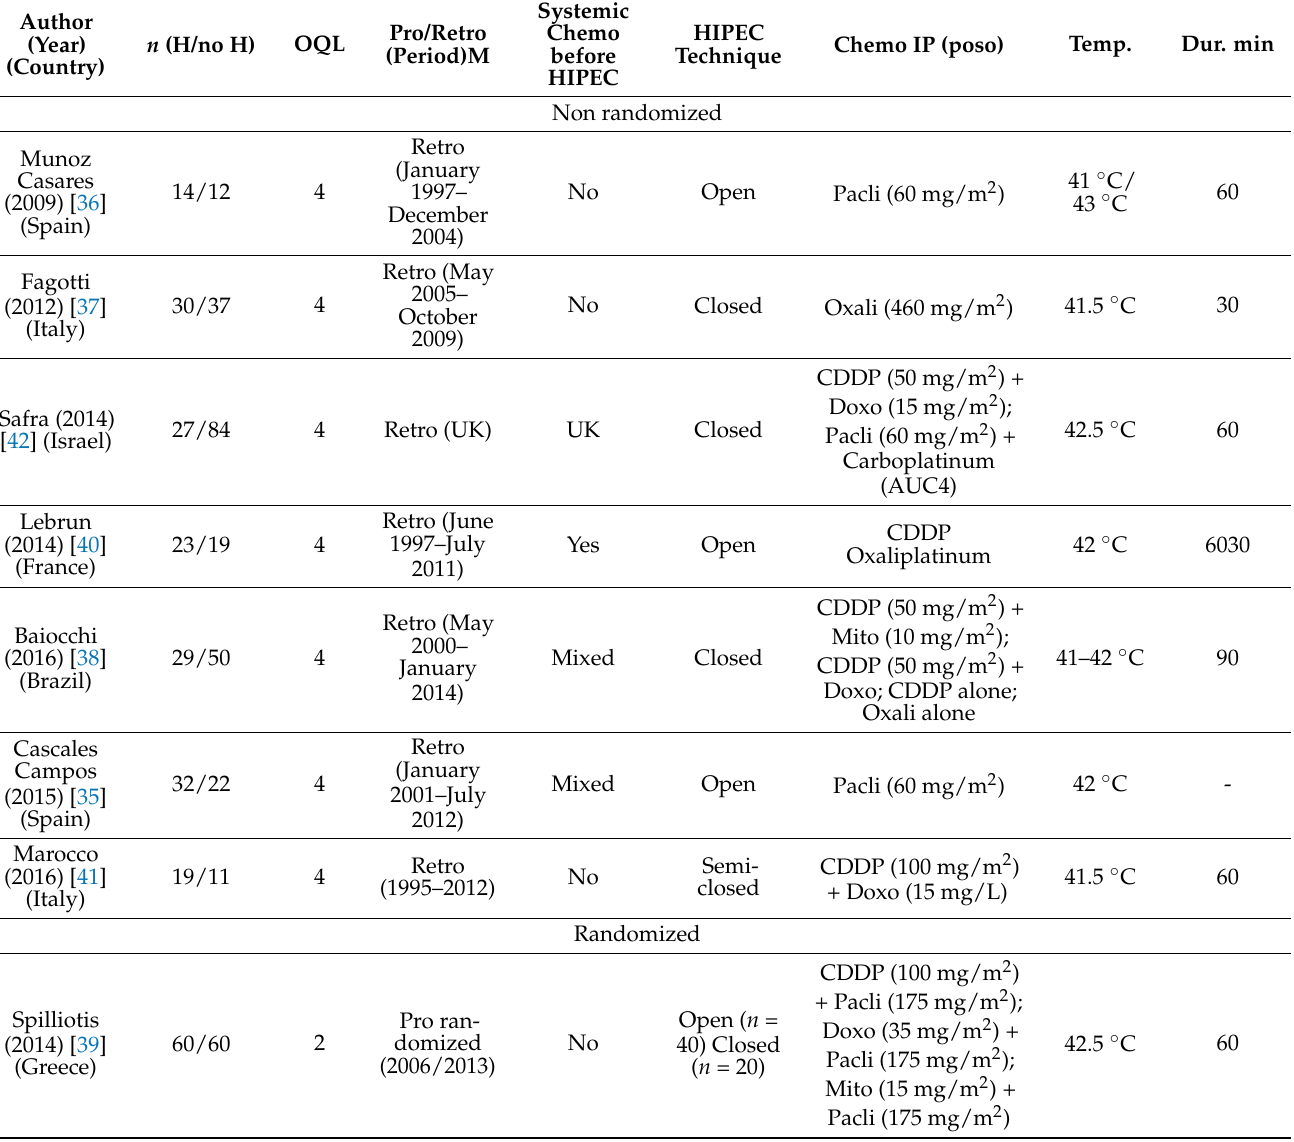
Table 3. Characteristics of the series of cytoreductive surgery and hyperthermic intraperitoneal chemotherapy (HIPEC) for ovarian cancer first relapse with a control group. (PIC O : Population: ovarian cancer first relapse, Intervention: HIPEC, Comparators: HIPEC characteristics, such as intraperitoneal drug, posology, temperature, duration, no HIPEC